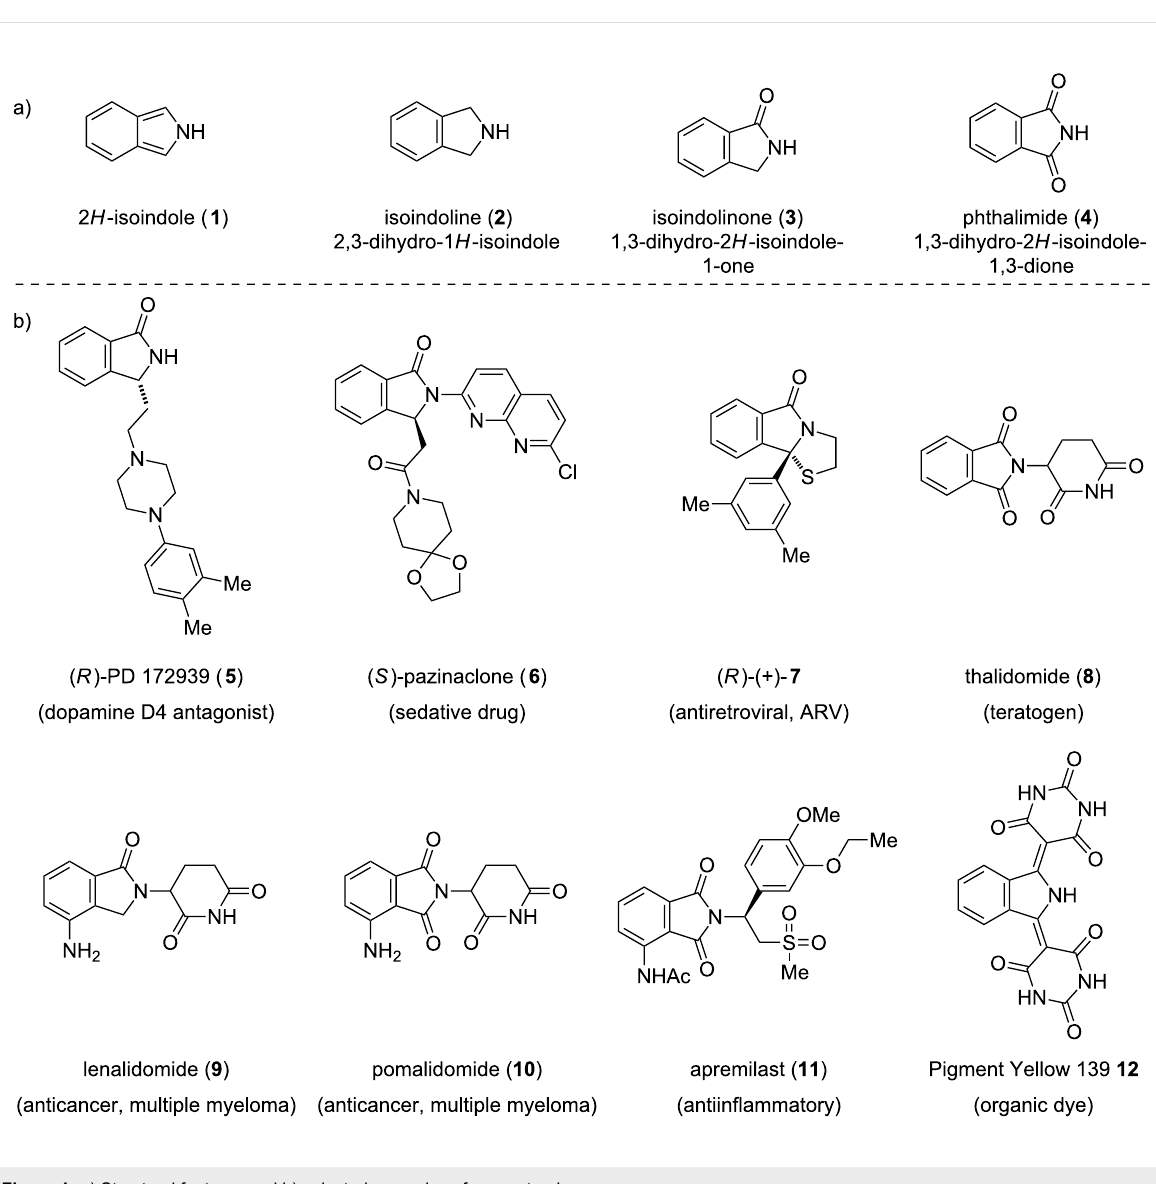
Figure 1: a) Structural features and b) selected examples of non-natural